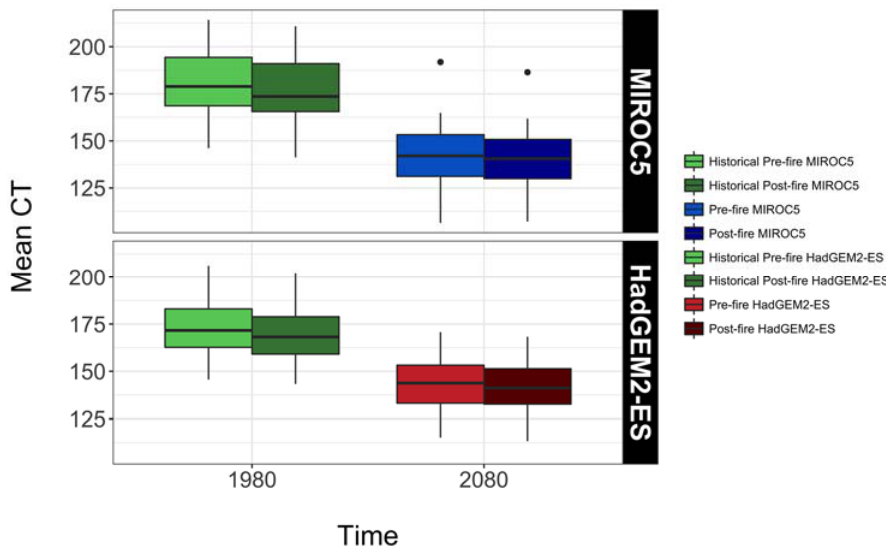
Figure 5. Mean center timing (CT) of flow for MIROC5 in RCP 4.5 and HadGEM2-ES in RCP 8.5 before and after forest cover reduction in comparison to historic conditions. Table 3. Ensemble mean center timing (CT) of flow before forest cover reduction in historical conditions (1980s), in the 2050s and in the 2080s, in comparison to MOROC5 in RCP 4.5 and HadGEM2-ES in RCP 8.5 in the 2080s before and after forest cover reduction. Ensemble Mean MIROC5 HadGEM2-ES Hist. RCP 4.5